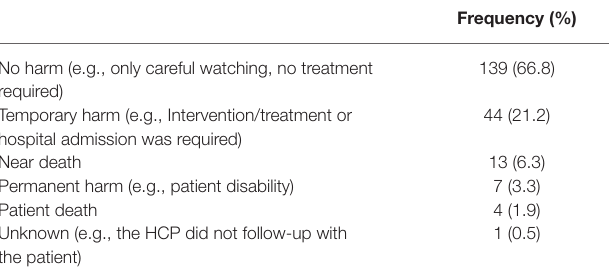
TABLE 7 | The potential impact and consequences of MEs on patients’